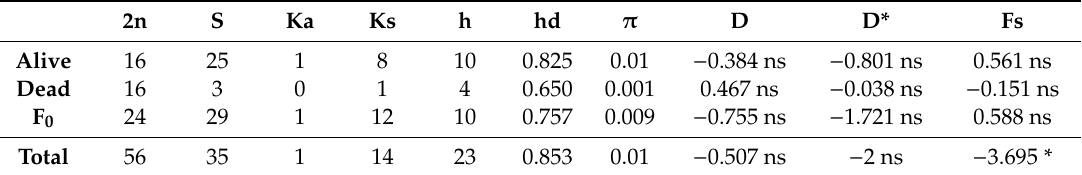
Table 1. Summary statistics for polymorphism in Ace-1 gene including the G119S mutation in A. gambiae mosquito population from Bankeng, Central